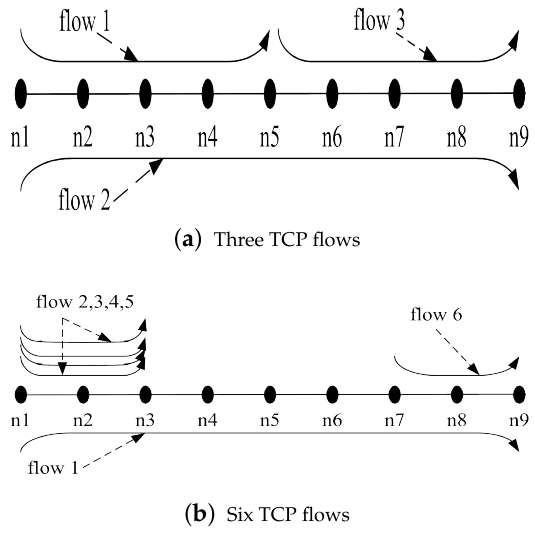
Figure 8. Simulation scenario with different